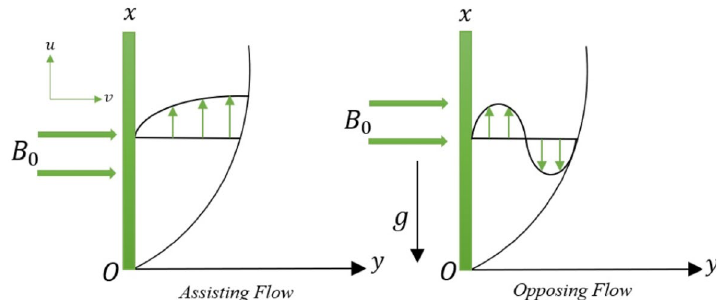
Figure 1. Flow geometry.